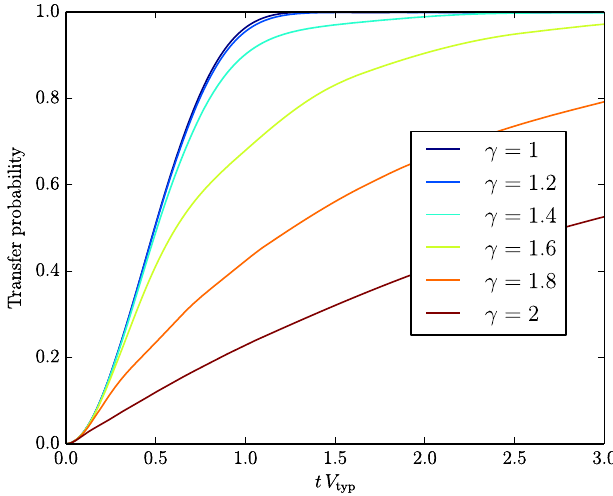
27. Population transfer probability as a function of time t in units of 1 =V for various values of parameter γ ¼ 2 a . typ